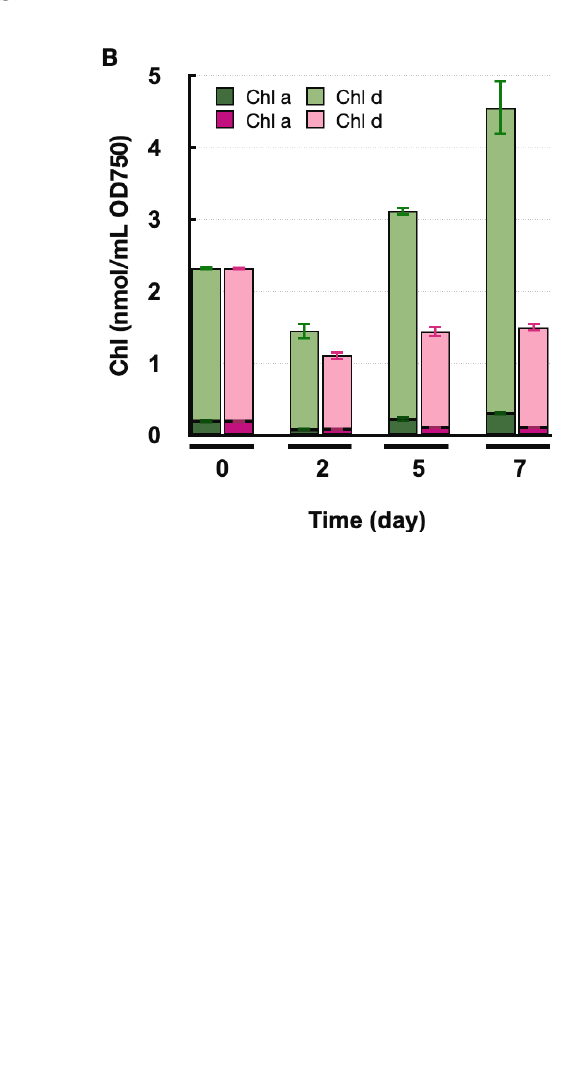
Figure 4. Anoxic growth and Chl a / d content in A. marina. ( A ) A. marina was grown under anoxic and light conditions (green circle) and anoxic and dark conditions (pink square). ( B ) The amounts of Chl a (dark green/dark pink) and Chl d (green/pink) were measured on days 0, 2, 5, and 7 of cultivation in anoxic light (green) and anoxic dark (pink) conditions, respectively. ( C ) The ratio of cellular Chl a / d amount in anoxic light conditions (green circle) and anoxic dark conditions (pink square).